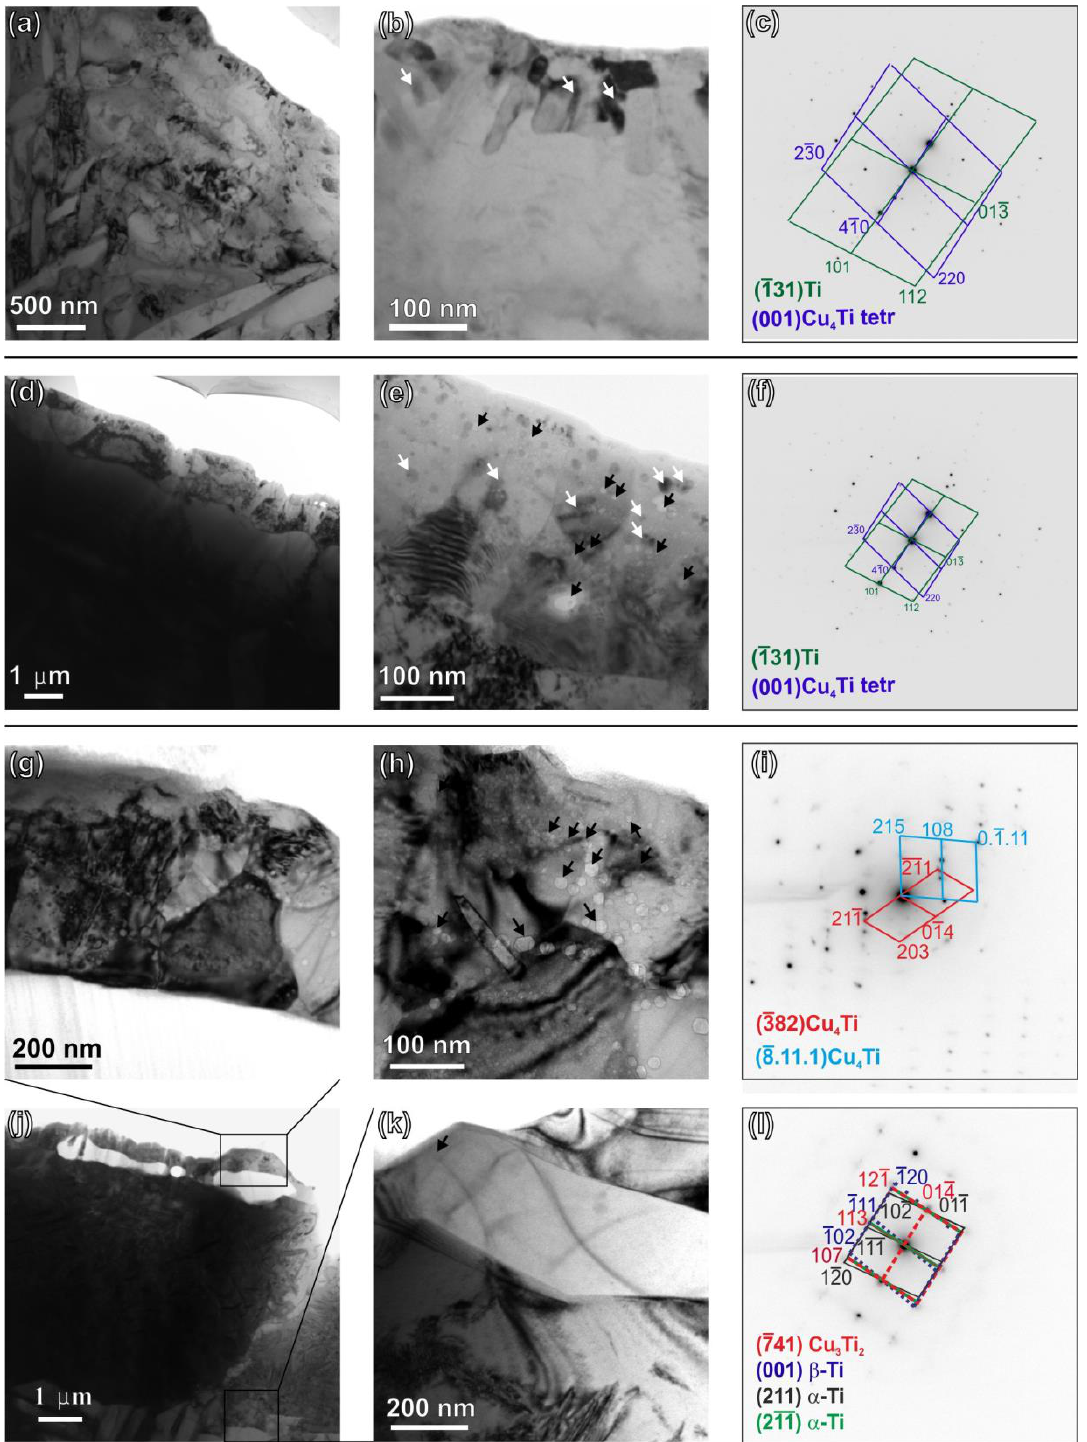
Figure 3. TEM images of the cross-section of the titanium alloy modified with copper ions: during 3 min ( a – c ), bright-field images, microdiffraction, and indication schemes; during 6 min ( d – f ), bright-field images and indication schemes; within 7.5 min ( g – l ). The white arrows show the indicated phases, the black ones — the pores.